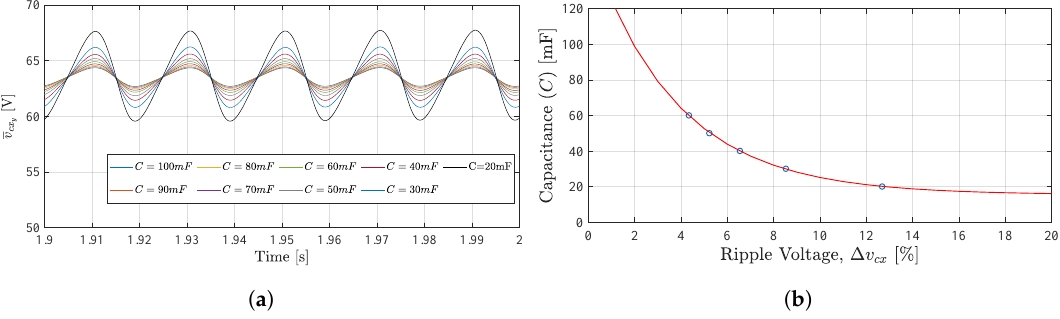
Figure 3. ( a ) Sub-module capacitor voltages for different value of capacitance ranging from 20 mF to 100 mF in steps of 10 mF. ( b ) Sub-module capacitance as a function of ripple voltage at maximum rated capacity of the plant operating with 10 kHz switching frequency.